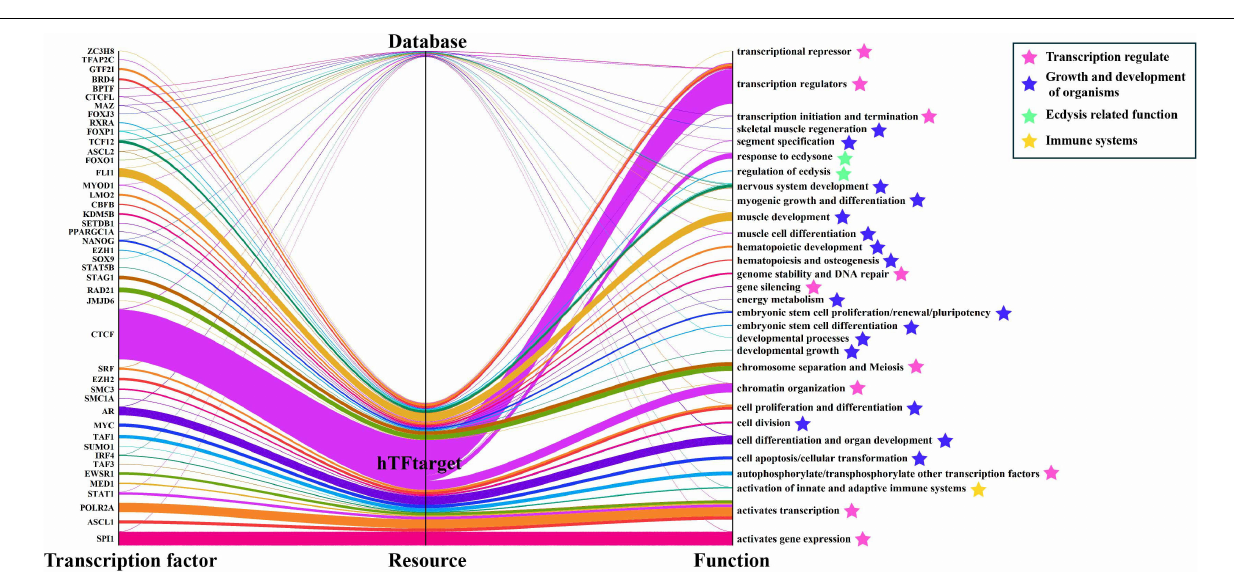
FIGURE 4 | LvGSK3 transcription factors’ resource and their main functions. The results of transcription factor stem from Ensembl and hTFtarget database. hTFtarget: a comprehensive database for regulations of human transcription factors and their